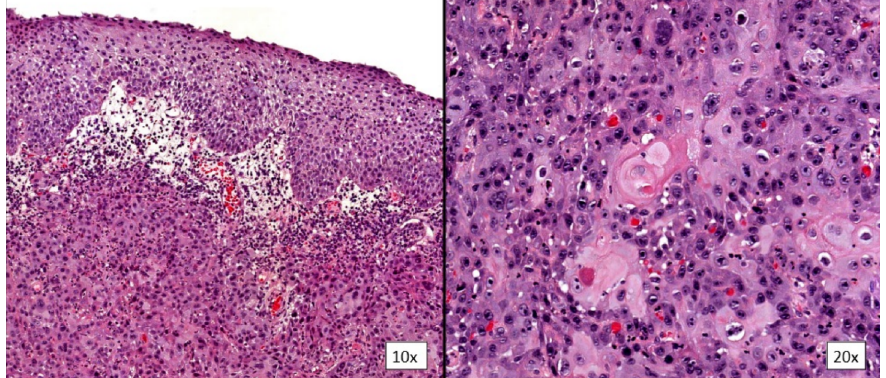
Figure 5: Anatomopathological study: moderately differentiated squamous cell carcinoma was confirmed; tumour cells present in corion